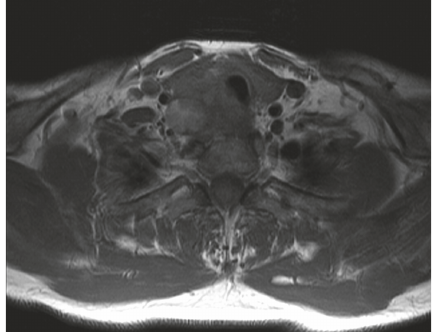
Figure 2: T1 MRI of neck showing invasion of trachea.